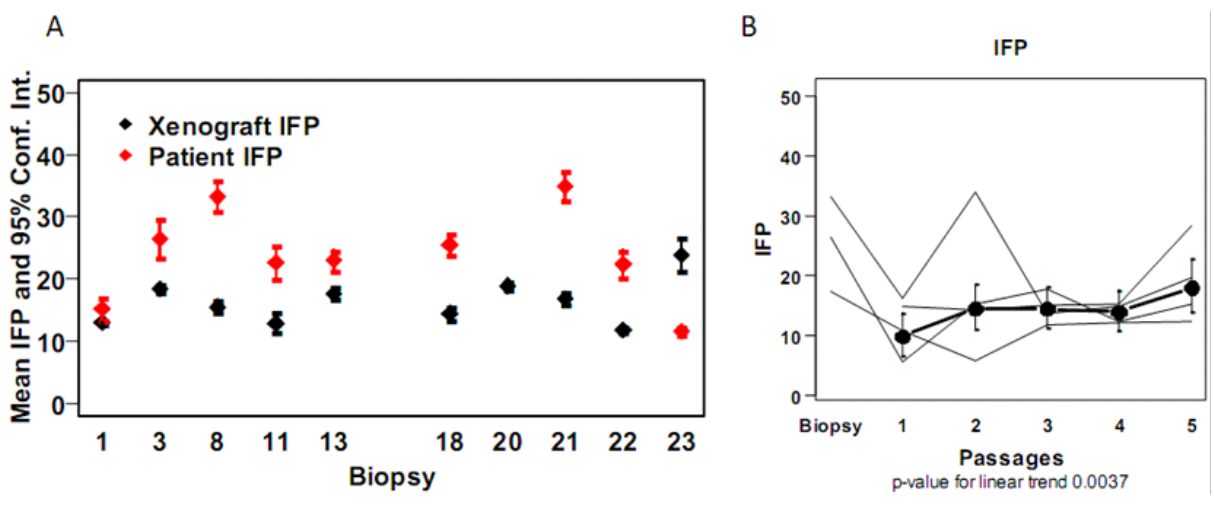
Figure 1. Interstitial fluid pressure levels in patient and the xenograft OCICx models. ( A ) IFP values are the mean ± SE mmHg with 3–4 measurements made for each tumor in all passages. Patient 16 did not have IFP measurements taken; ( B ) IFP (mmHg) measurements over passages for the OCICx 1, 3, 8, 16 are plotted with 95% confidence intervals at each passage individually and as a mean of the 4 models p value